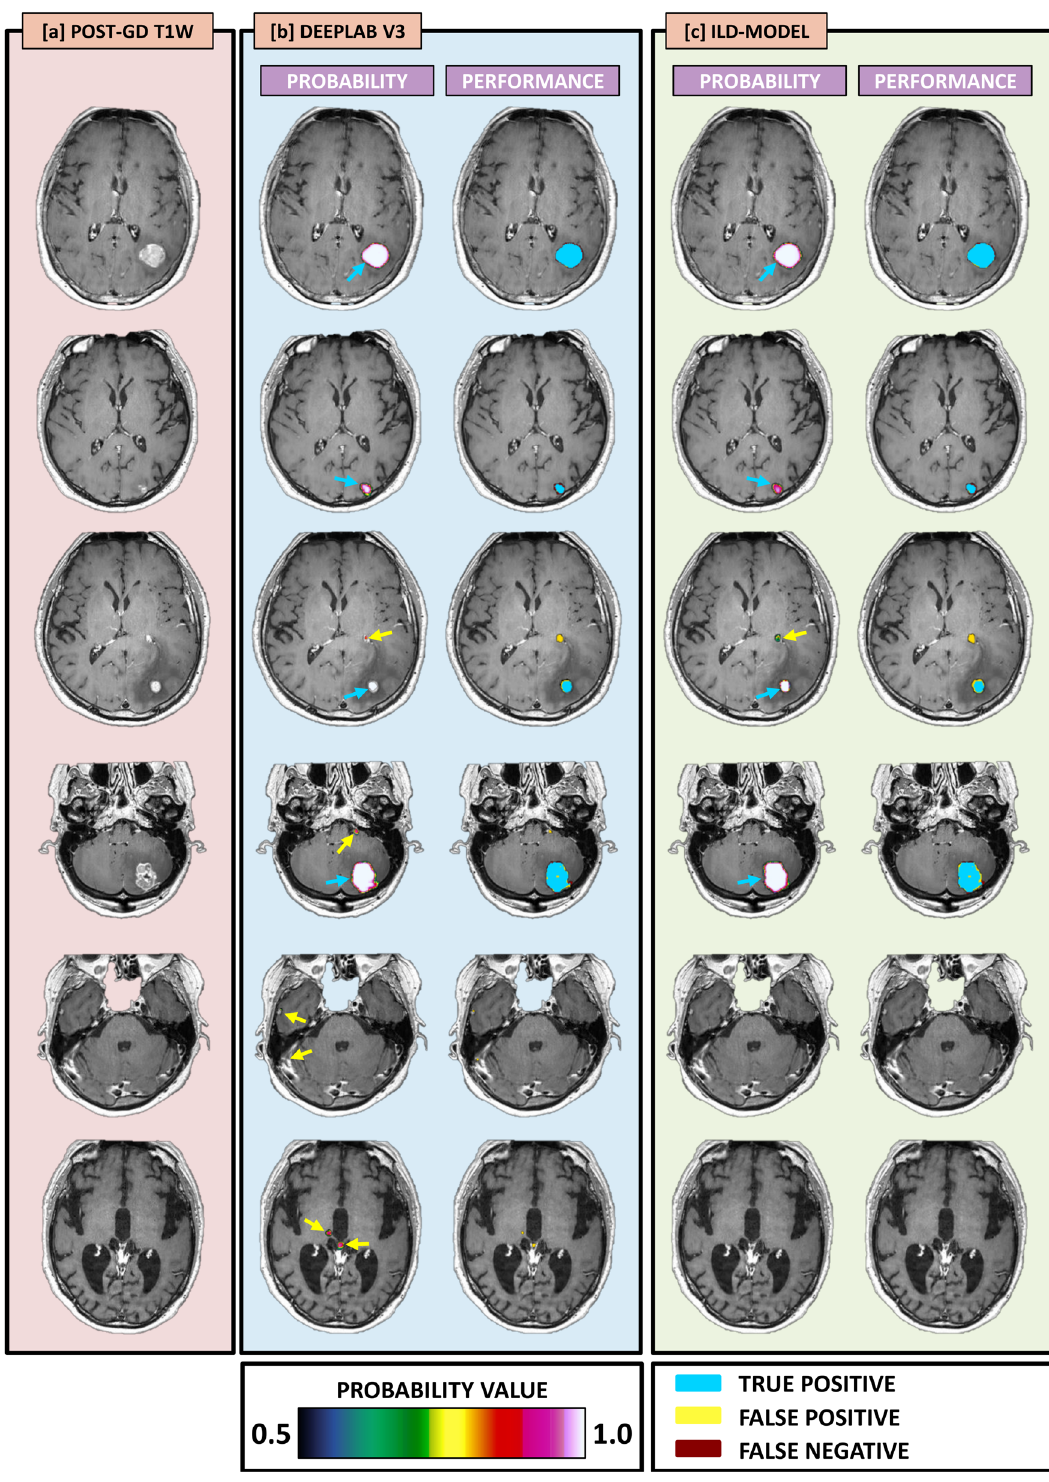
Fig. 1 Example cases — Examples in representative test set cases showing the segmentation predictions from the DeepLab V3 network and the ILD-method. The image mosaic shows the post-Gd 3D T1-weighted image-series ( a ), and the predictions as probability maps (voxel- wise ranging from 0.5 to 1 as indicated by the color bar) and performance maps (classi fi ed as true negative, false positive, and false negative as speci fi ed by the color code) from the DeepLab V3 network ( b ) and the ILD-method ( c ). All maps are shown as overlays on a post-Gd 3D T1- weighted image-series. The cases shown here are [ fi rst row] a 65-year-old female with malignant melanoma, [second row], 73-year-old male with non-small cell lung cancer (NSCLC), [third row] 66-year-old male with NSCLC, [fourth row] 44-year-old female with NSCLC, [ fi fth row] 64- year-old female with NSCLC, and [sixth row] 73-year-old male with NSCLC. The blue arrows indicate true positive lesions, while yellow arrows indicate false positive lesions. Note that in the bottom three cases, the DeepLab V3 returns several false positive lesions which are not reported by the ILD-method, thus re fl ecting the results indicating a superior performance on false positive rate by the